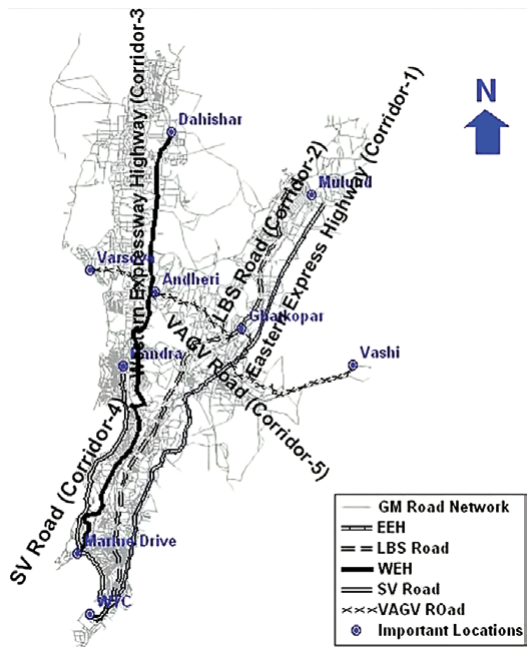
Fig. 1. Map showing selected corridors of greater